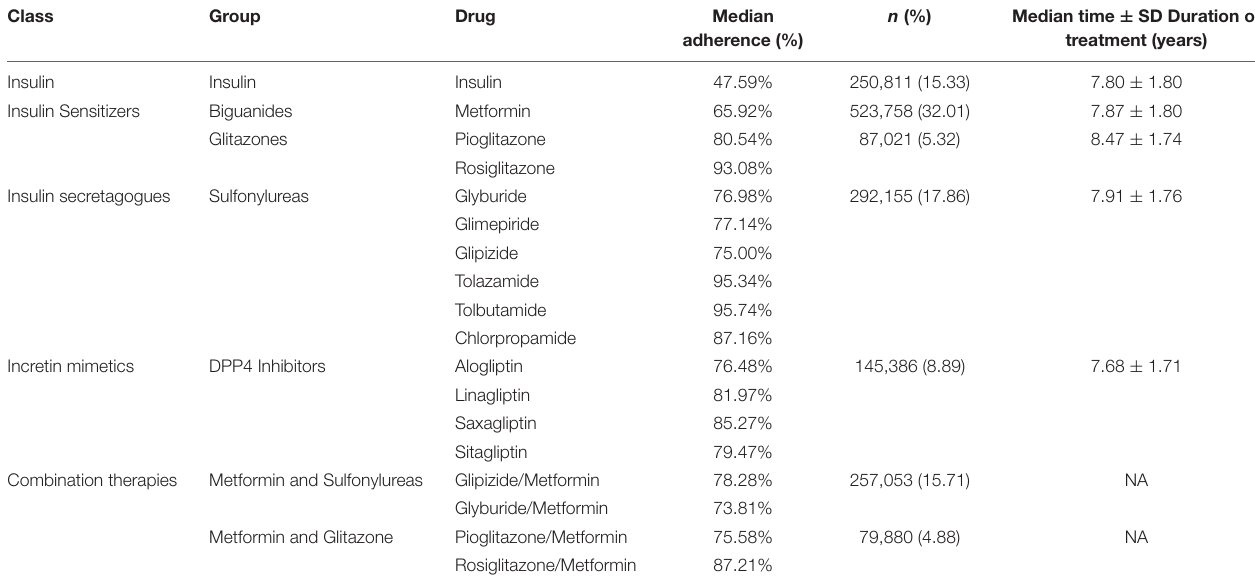
TABLE 1 | List of anti-hyperglycemic therapeutics and number of